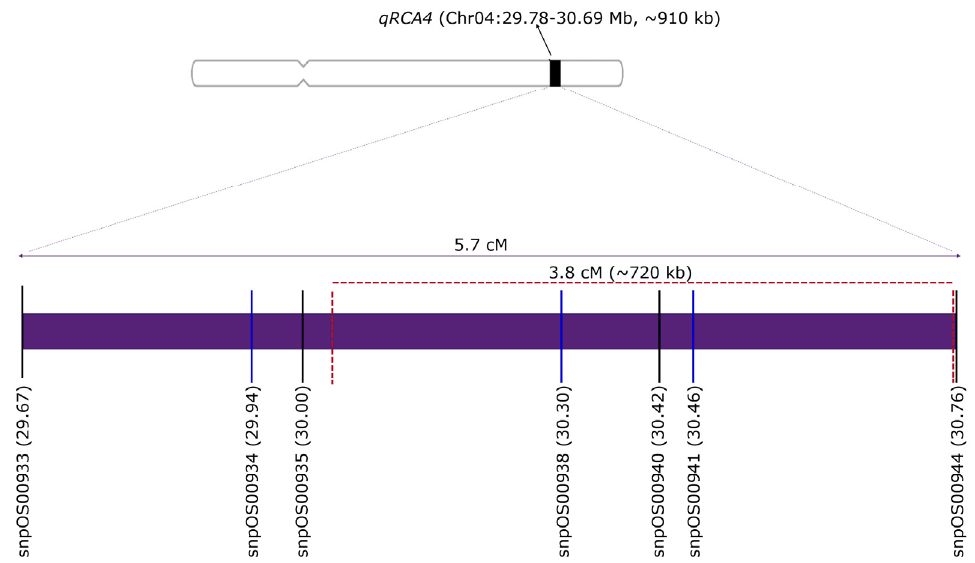
Figure 1. Molecular map of qRCA4 using newly designed molecular markers and validation results from two populations. Black lines indicate polymorphic markers between IRAT109 and other check genotypes used, while blue lines indicate monomorphic markers between IRAT109 and Norin PL8. Red dashed lines indicate the new confidence interval computed.